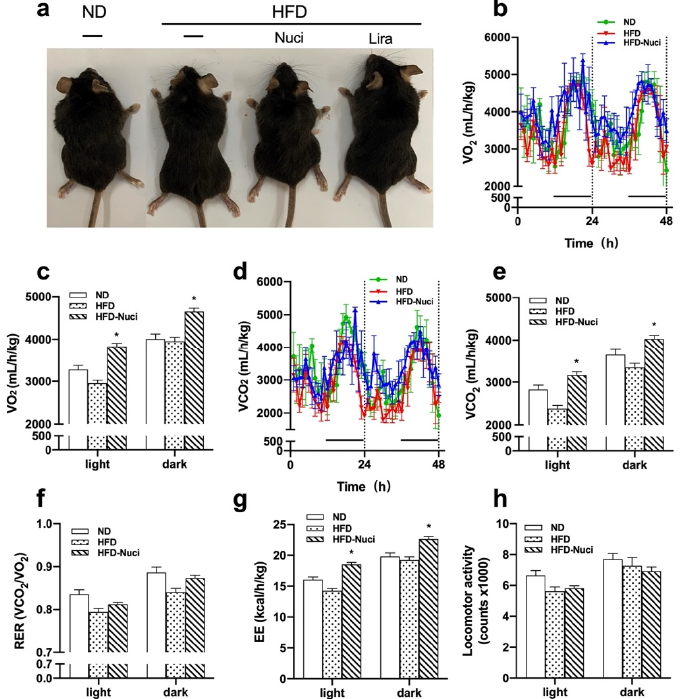
Figure 3. Nuci increased energy metabolism in HFD-fed mice. Seven-weeks male C57BL/6J mice were fed with ND, HFD, HFD supplemented with Nuci and HFD with subcutaneous injection of Lira at 200 μ g/kg/day for 12 weeks. General pictures of mice in ND, HFD, HFD-Nuci, and HFD-Lira group were presented ( a ). After 11 weeks of treatment, mice in the ND, HFD, and HFD-Nuci group were placed in metabolic cages at 22 °C at 12 h light–dark cycle. VO 2 ( b ), VCO 2 ( d ) were detected and quantification of VO 2 ( c ), VCO 2 ( e ), RER ( f ), EE ( g ), and locomotor activity ( h ) during both the light and dark cycle were determined by Promethion. Data were presented as mean ± SE, n = 4 in each group. * p < 0.05 vs. the HFD group.